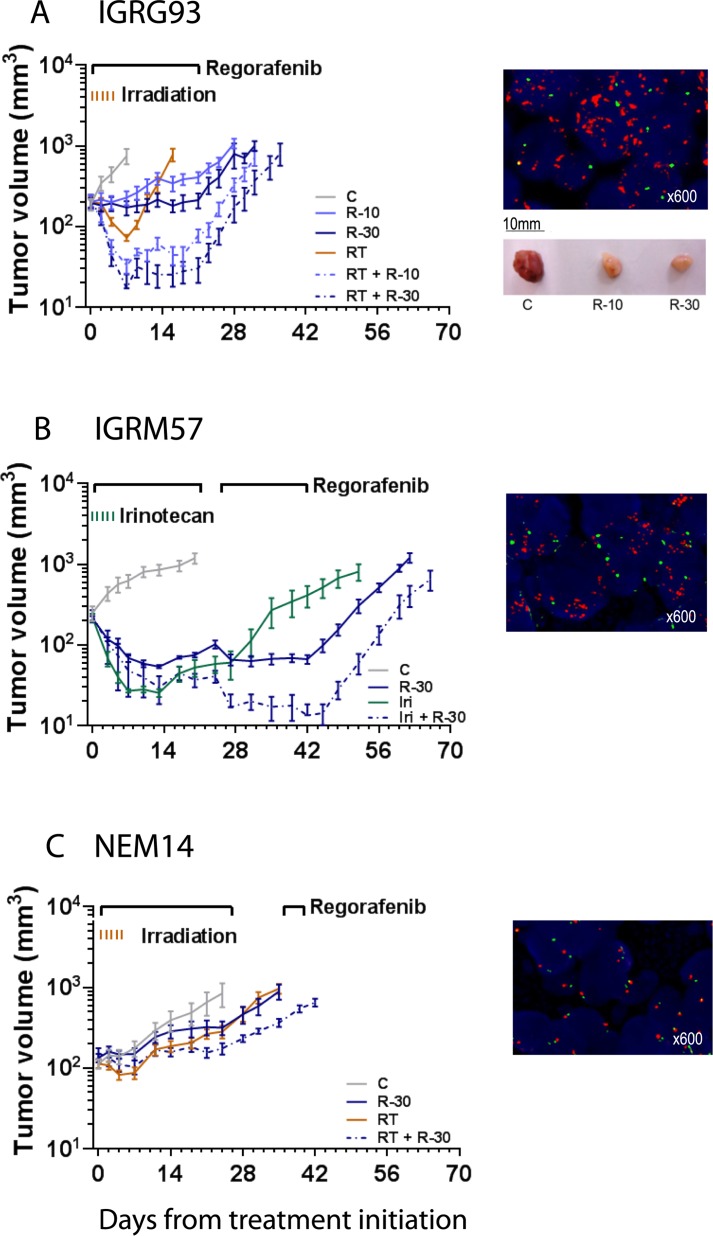
Antitumor activity of regorafenib alone and in combination against xenografts of PDGFRA amplified (IGRG93 and IGRM57), and non-amplified (NEM14) brain tumors.Animals bearing subcutaneous (A) IGRG93 and (C) NEM14 gliomas, and (B) IGRM57 medulloblastoma, were treated orally with regorafenib at 10 mg/kg/d (R-10) and/or 30 mg/kg/d (R-30) for a minimum of 21 days, total body irradiation of 1 Gy (RT) for 5 consecutive days (IGRG93, NEM14), or irinotecan at 27 mg/kg intravenously (Iri) for 5 consecutive days (IGRM57), respective combinations thereof as indicated, or vehicle (C). Graphs show arithmetic means ± SEM of tumor volumes of 6–14 tumors per group. Bars above graphs indicate treatment periods. Fluorescence in situ hybridization for PDGFRA gene amplification is shown in the right upper corner for each model (PDGFRA gene in red, centromere of Chromosome 4 in green); picture shows macroscopic aspect of IGRG93 tumors after 3 days of treatment.